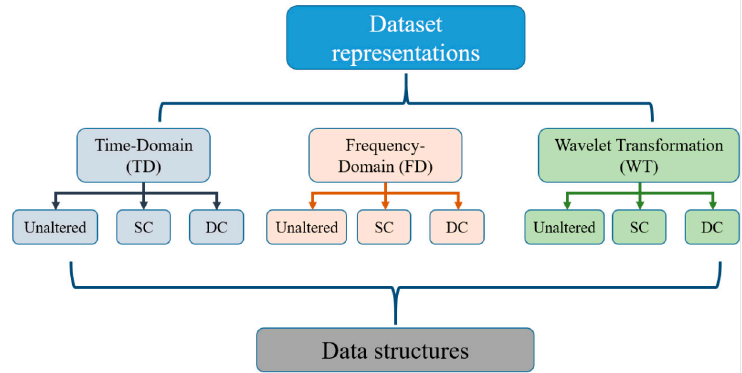
Figure 9. Input data representation and